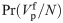
Comparing the influence with stubbornness model to null models.We compare the influence with stubbornness model fit to the one- and two-mode null models and the two-timescale model for the CA 12-juror data with Ttrial equal to 6-8 hours. These figures serve as examples of the typical fit quality. (a) Pr(Vpf/N) versus Vpf/N, (b) Pr(T ≥ Tdelib) versus Tdelib, and (c) 〈Tdelib〉 versus Vpf/N.